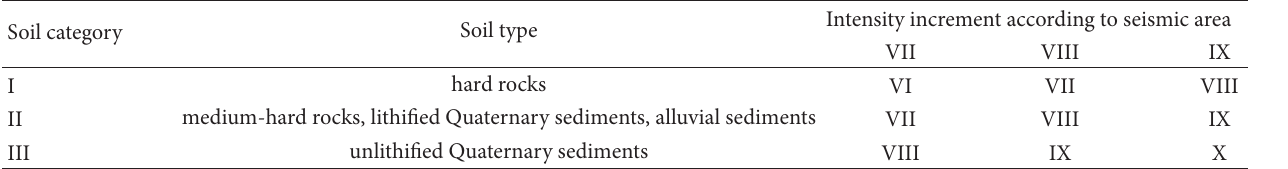
Table 3: Soil categories for seismic microzonation according to Medvedev method (after [3]). Soil